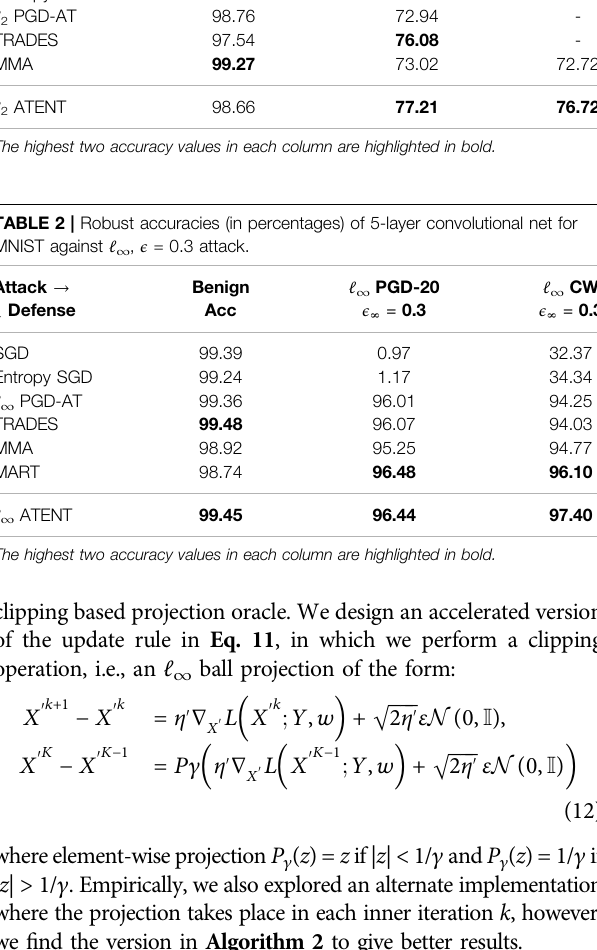
TABLE 1 | Robust percentage accuracies of 5-layer convolutional net for MNIST against ℓ 2 , ϵ (cid:1) 2 attack.